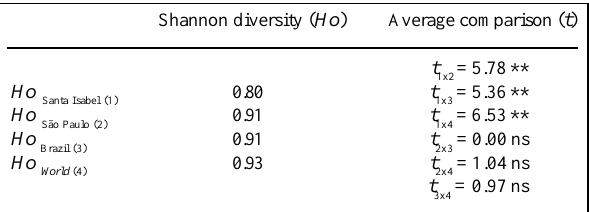
Table IV - Shannon genetic index for the four cassava cultivar groups and comparisons of their averages by t -test (Student-Fisher). Shannon diversity ( Ho